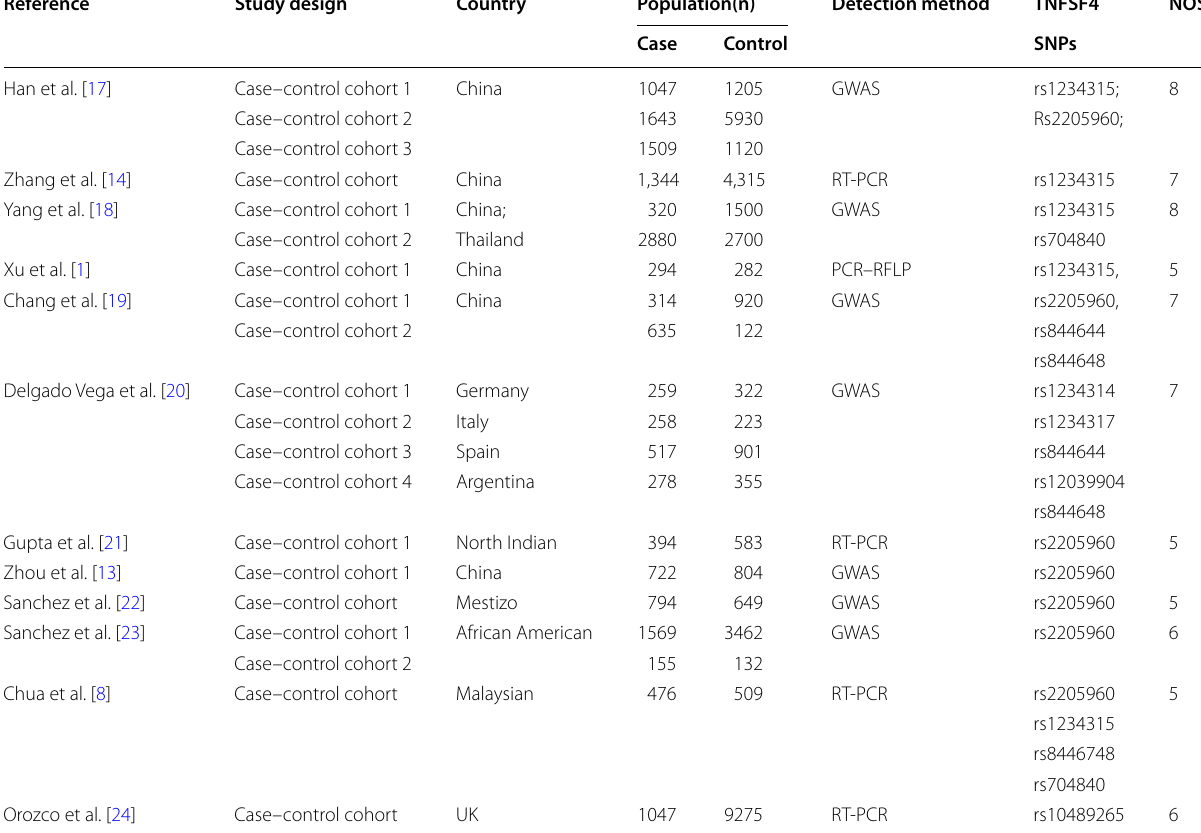
Table1 Characteristics of eligible studies in